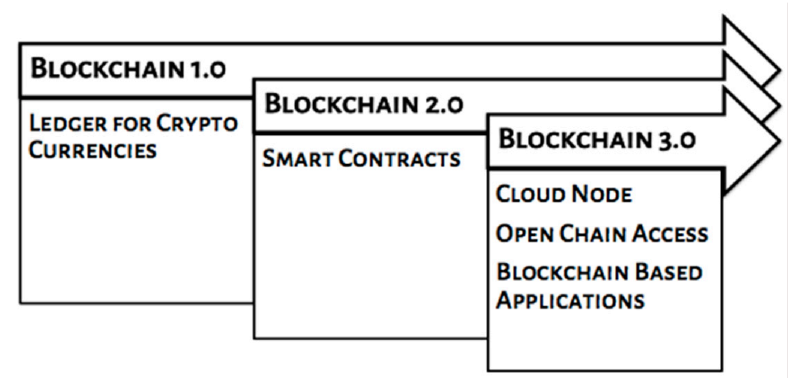
Figure 1. Stages of Blockchain